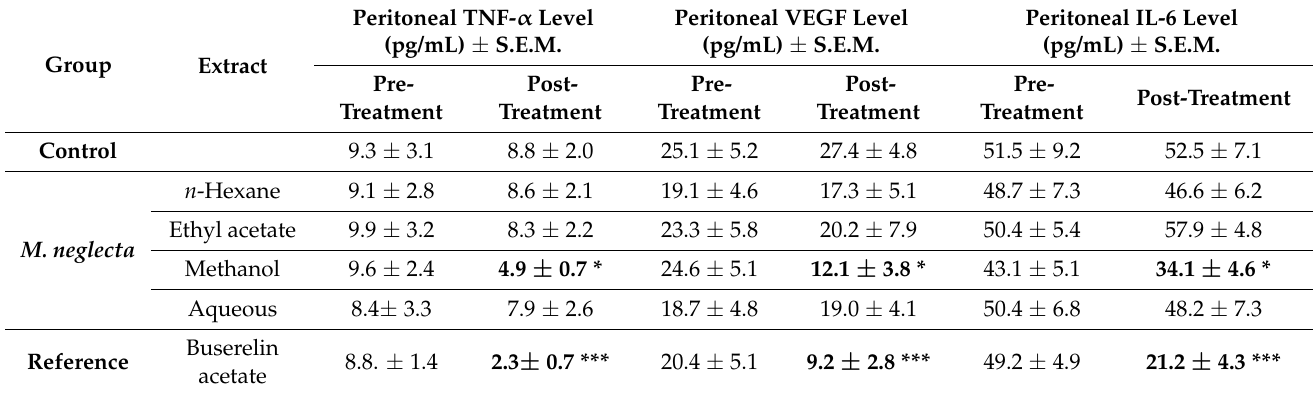
Table 3. The effect of M. neglecta on cytokine levels in peritoneal fluids in a rat endometriosis model.